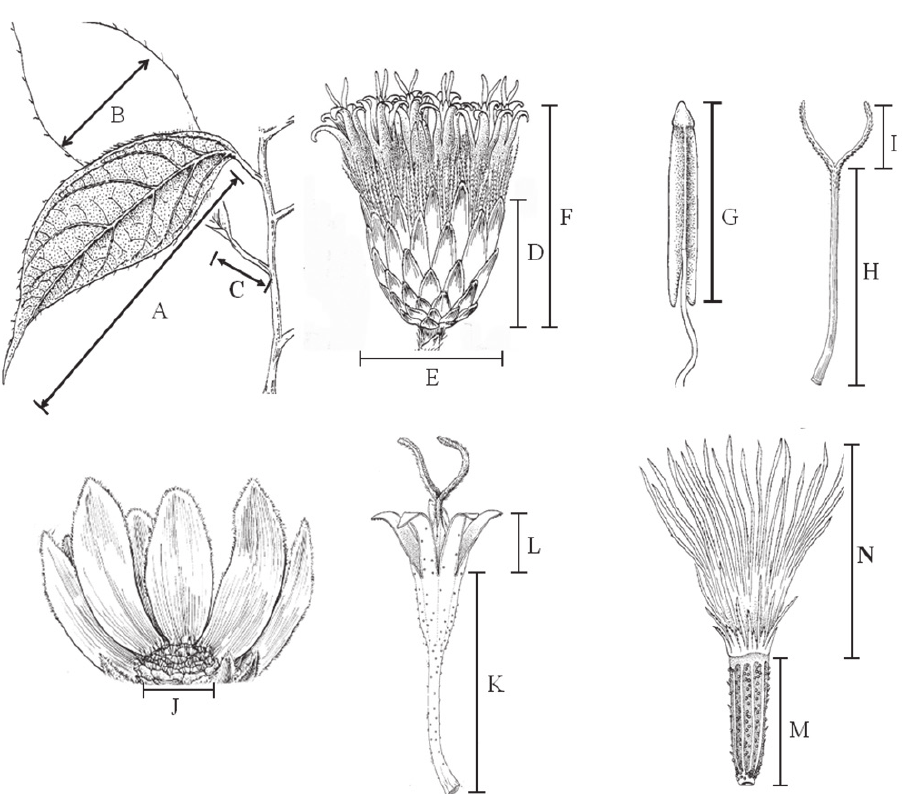
Figure 1. Illustration of characters used in morphological descriptions and UPGMA analysis. A Leave length B Leave width C Petiole length D Involucral length E Involucral diameter F Capitula height G Anther length H Style length I Stigma length J Receptacle diameter K corolla tubescorolla tube length L Corola lobe length M Achene length N Inner pappus length (Modified from Robinson